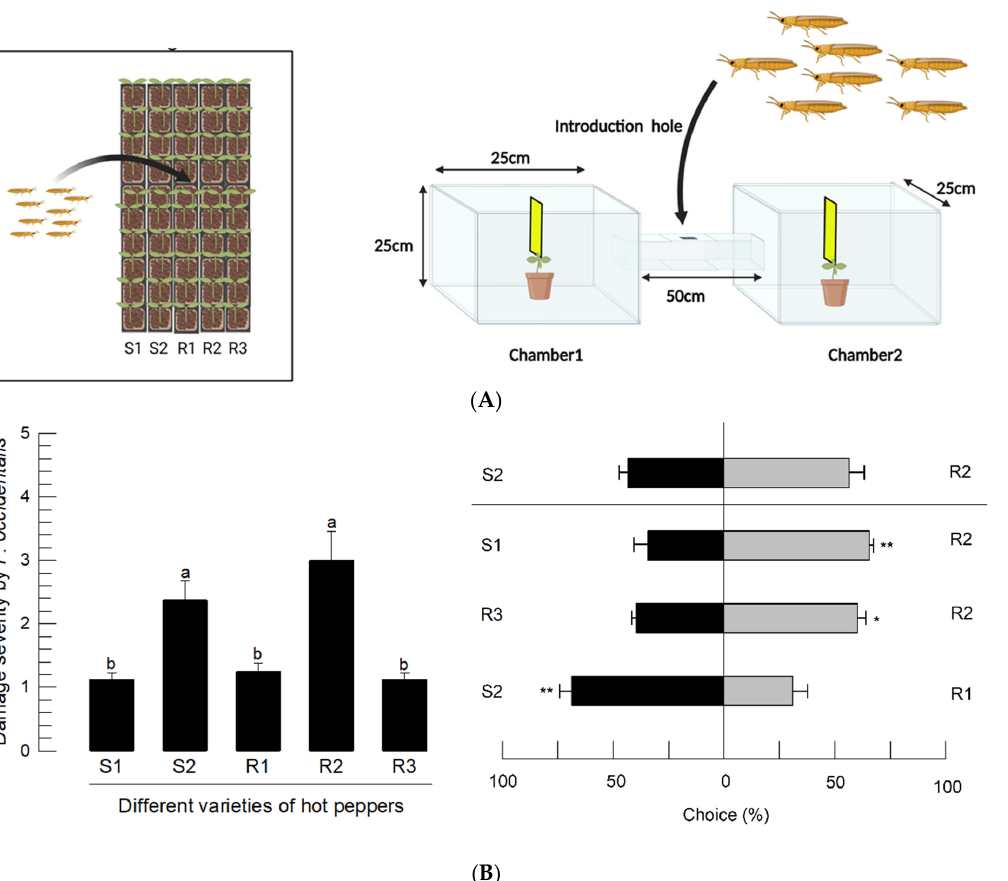
Figure 4. Variations among different hot pepper varieties for susceptibility to F. occidentalis . ‘S’ and ‘R’ stand for susceptibility or resistance to TSWV infection. ( A ) Feeding damage analysis of the hot pepper varieties to F. occidentalis . After 100 adults were released into the plastic bag (100 L), they were allowed to choose and feed on the hosts. After 7 days, feeding damage severity was graded using the criterion described in Figure S1. Each treatment was replicated three times. The letters above the standard deviation bars indicate significant differences among the means at type I error = 0.05 (LSD test). ( B ) Choice test of F. occidentalis adults between two hot pepper varieties via a two-armed tunnel assay. Different varieties of hot peppers were placed in each of the chambers with a yellow sticky trap to capture the thrips. A hundred adults were released at the entrance hole. Each treatment was replicated four times by exchanging the left and right positions. The asterisks above the standard deviation bars indicate significant differences between the means at Type I error = 0.05 (*) or 0.01 (**) (LSD